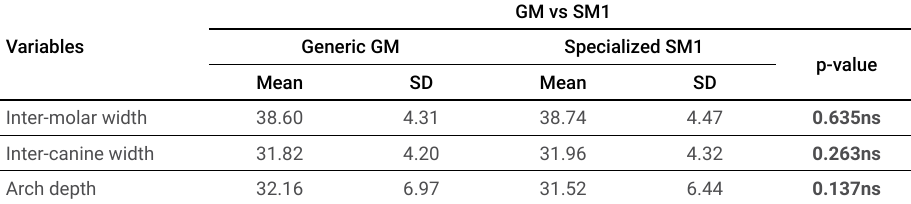
Table 1. Mean and standard deviation (SD) values of GM vs